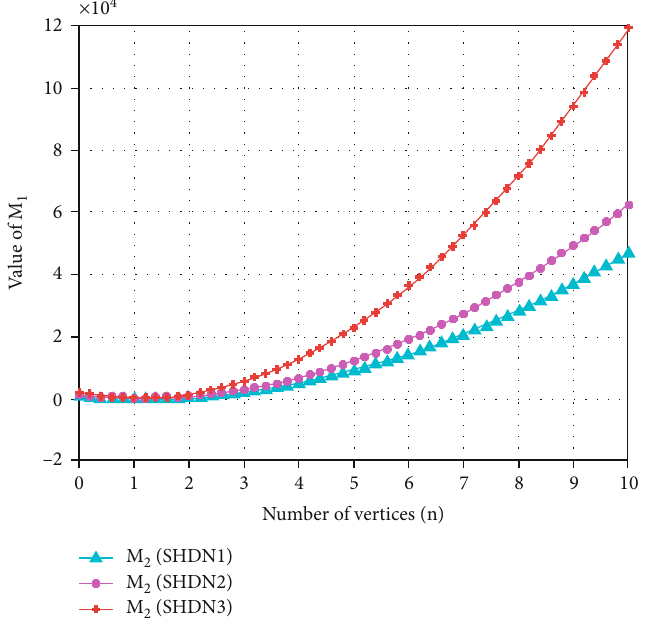
n Þ , Γ n Þ , and Γ n Þ using 2D graphs of SZI. 1 ð 2 ð 3 ð